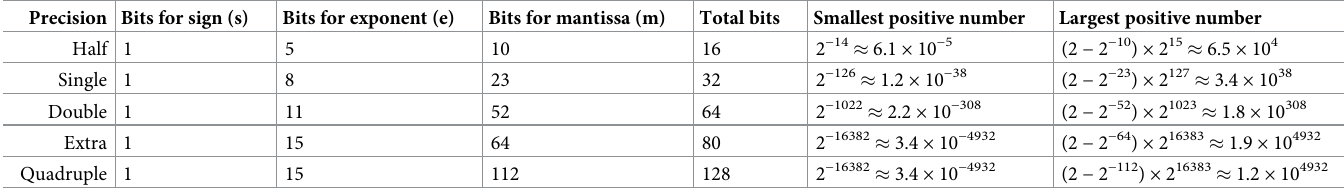
Table 1. Main characteristics of popular precision levels. Precision Bits for sign (s)